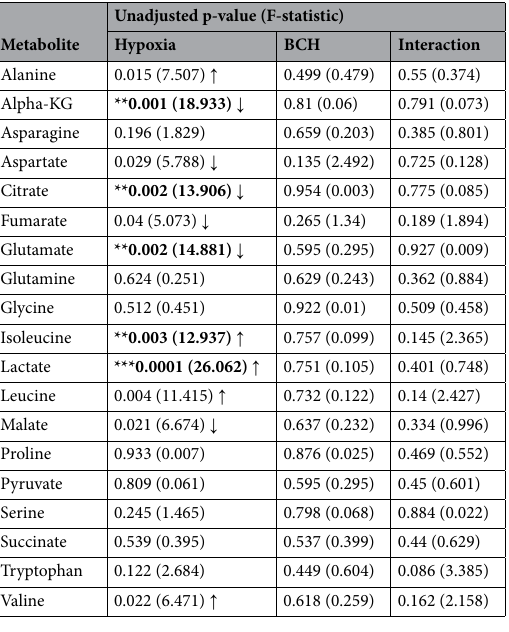
Table 1. List of intracellular metabolites examined along with their unadjusted p-value and F-statistic for main effects of hypoxia and BCH, as well as an interaction effect. Arrows indicating direction of change are present for all comparisons with p < 0.05. Values in bold remain significant after correction for multiple comparisons. ** indicates p < 0.01, *** indicates p <